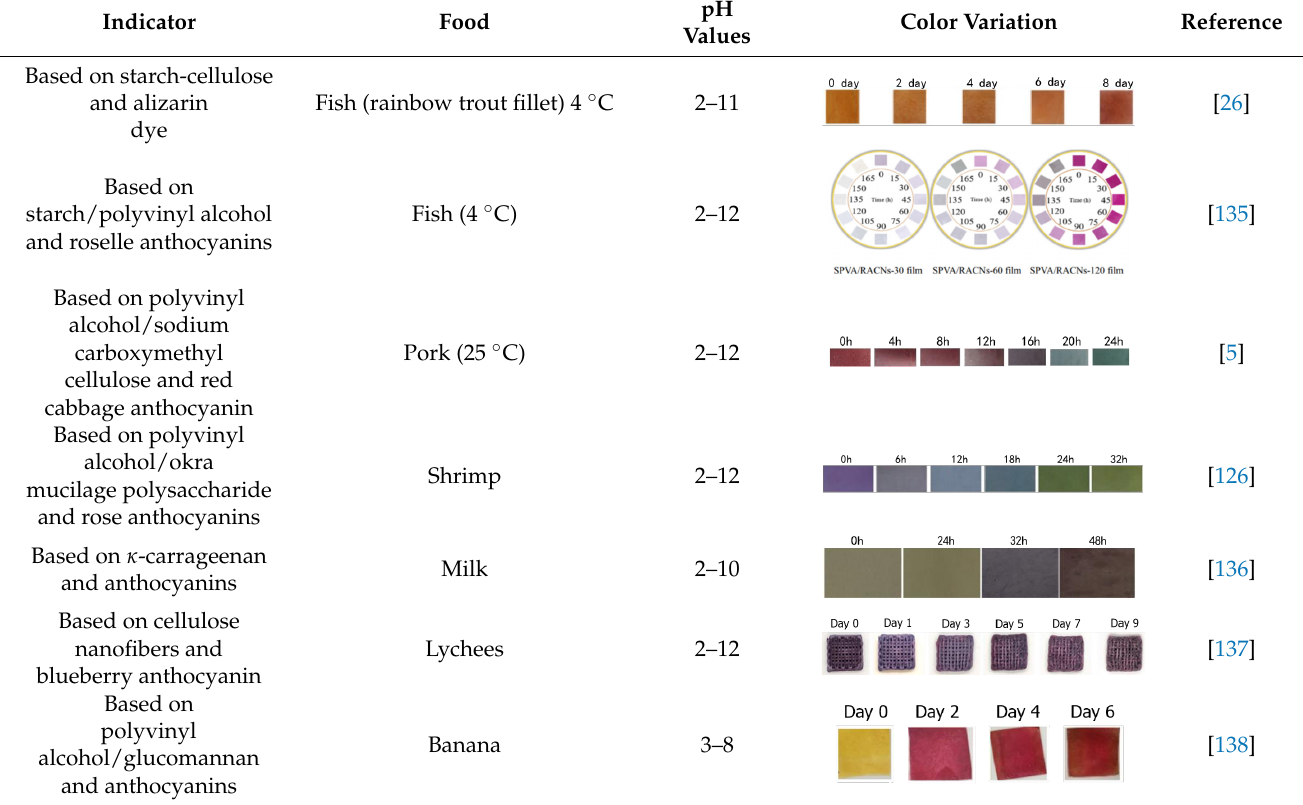
Table 3. The color variations of natural-colorants-based indicators used to monitor food freshness.